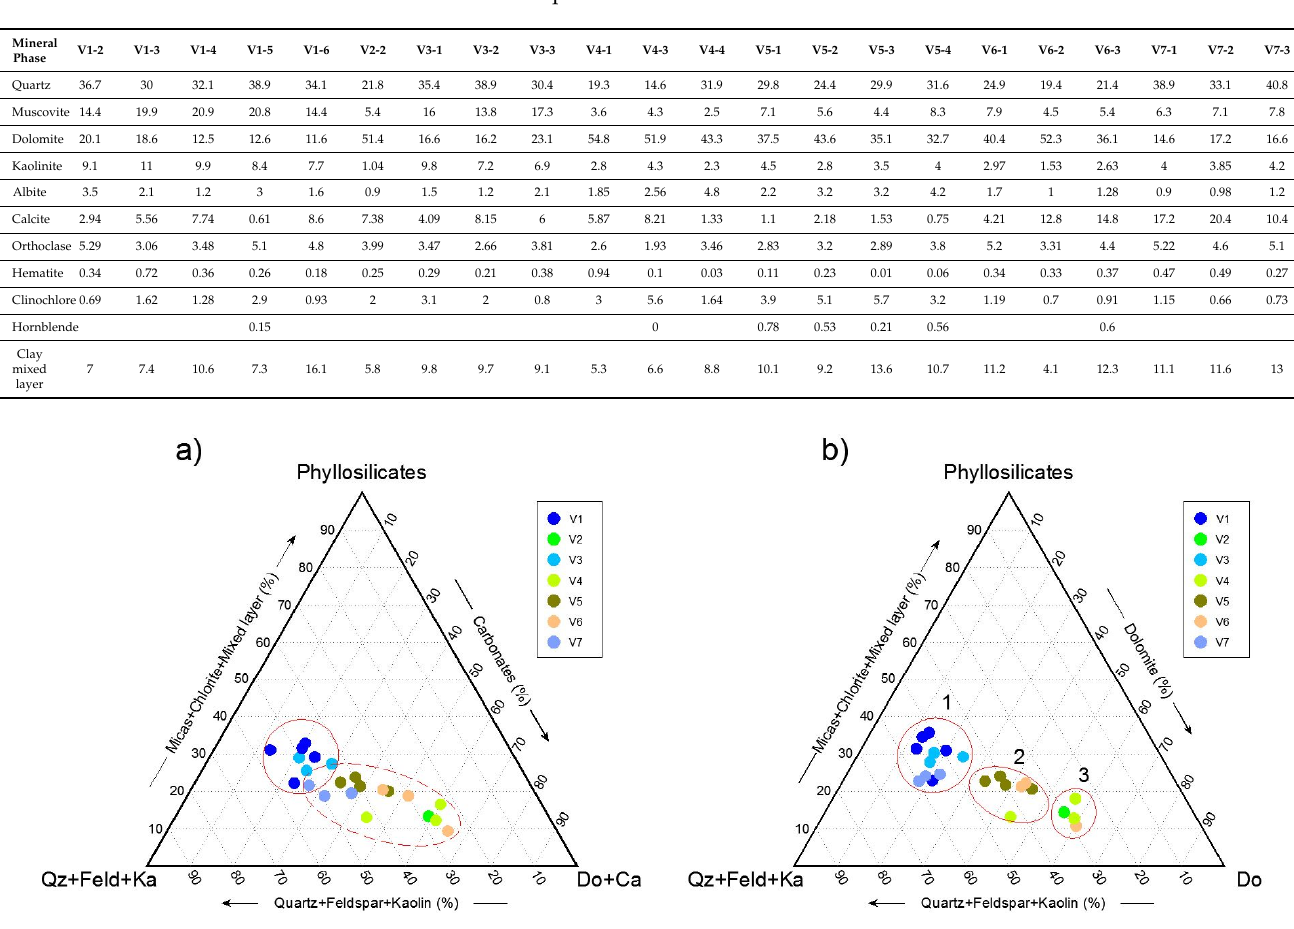
Figure 7. ( a , b ) Soil and subsoil mineralogy results from diffractometric analysis. Figure a bulk results. On figure ( b ) is the refinement of the results with weighted analysis. Removing the calcite component of strictly local origin, three groups of soils can be distinguished clearly, and their geopedology can be traced back to specific sedimentary processes and parent rocks: (1) silicate, (2) mixed terrigenous and (3) dolomitic. Main crystalline phases: Qz = quartz; Feld = feldspar; Do = dolomite; Ca = calcite; Ka = kaolinite. Kaolinite is mainly derived from feldspars and was, therefore, created with these minerals.